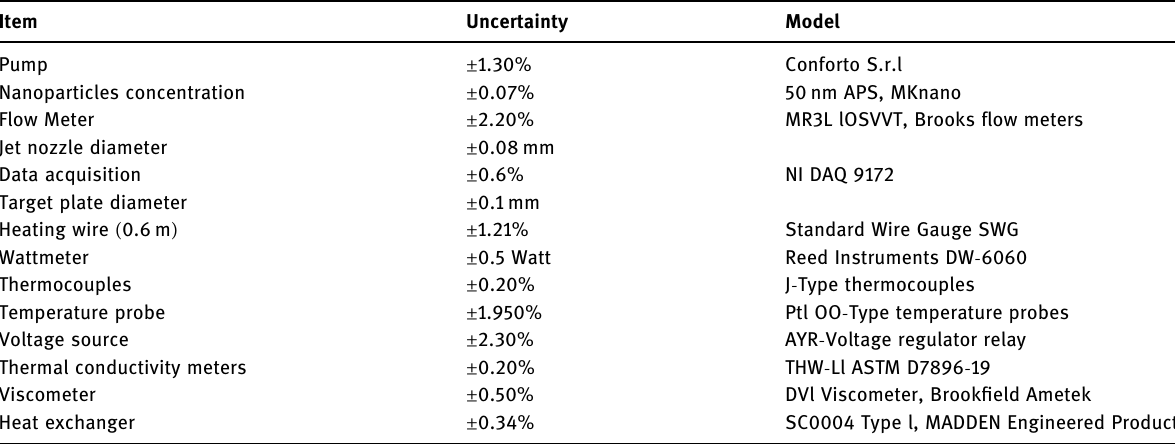
Table 1: Instruments uncertainties